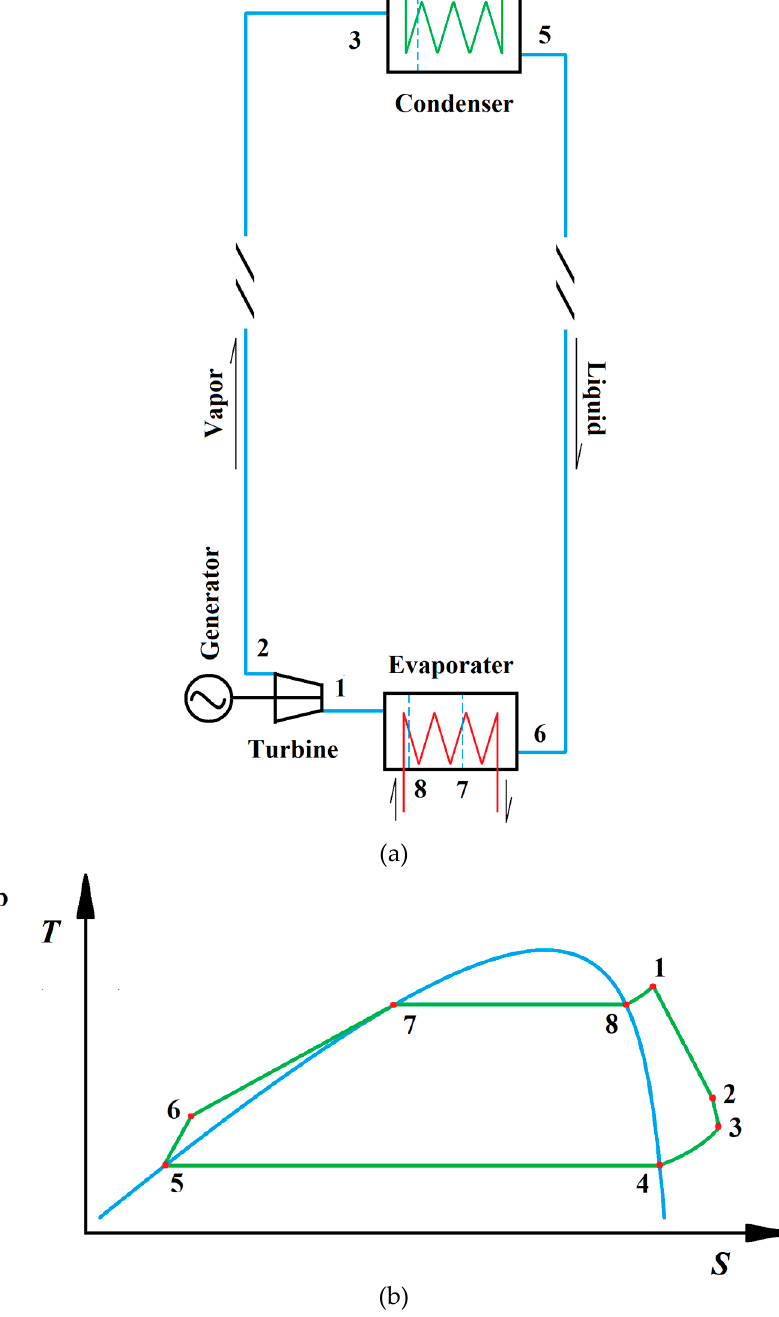
Figure 2. Sketch maps for GDOPC. (a) Flow chart system; (b) Cycle process.